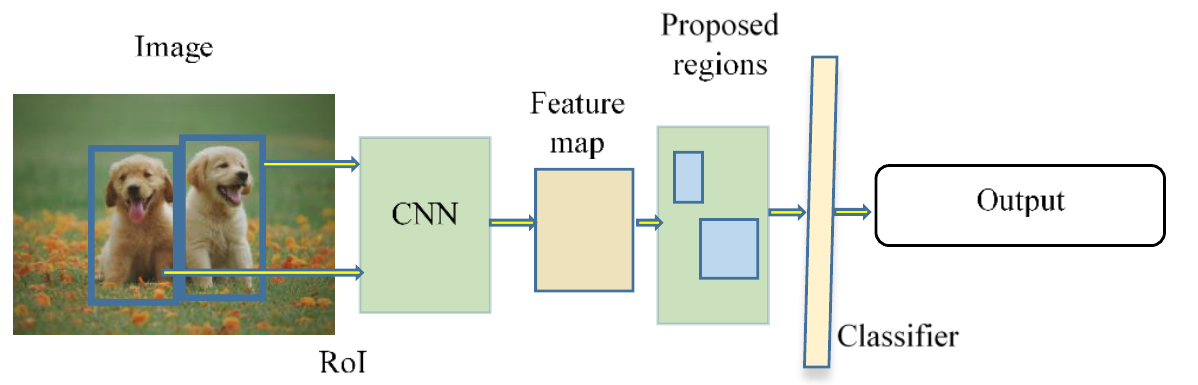
Figure 4. Faster R-CNN architecture where CNN is computed only for proposed regions. This process is repeated in the form of feature maps and region proposals followed by similar FC layers classifying in the end.